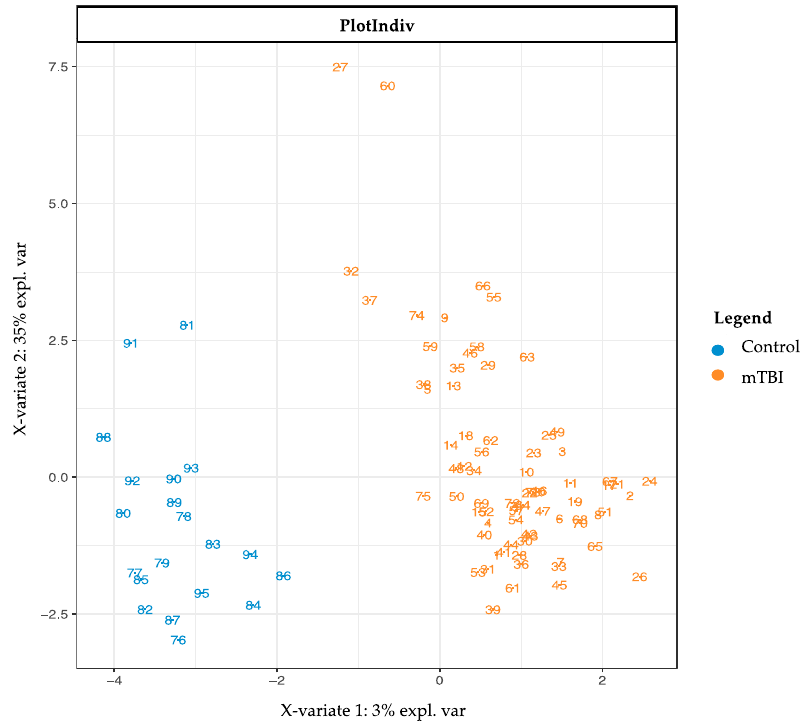
Figure 1. Sparse partial least squares discriminant analysis (sPLS-DA) plot. Note separation of subacute mTBI compared to TBI control data, as determined by metabolites making up the first two analytic components. The separation of the case and control groups is complete, without overlap. sPLS-DA = sparse partial least squares-discriminant analysis. Control = TBI control. mTBI = mild traumatic brain injury.